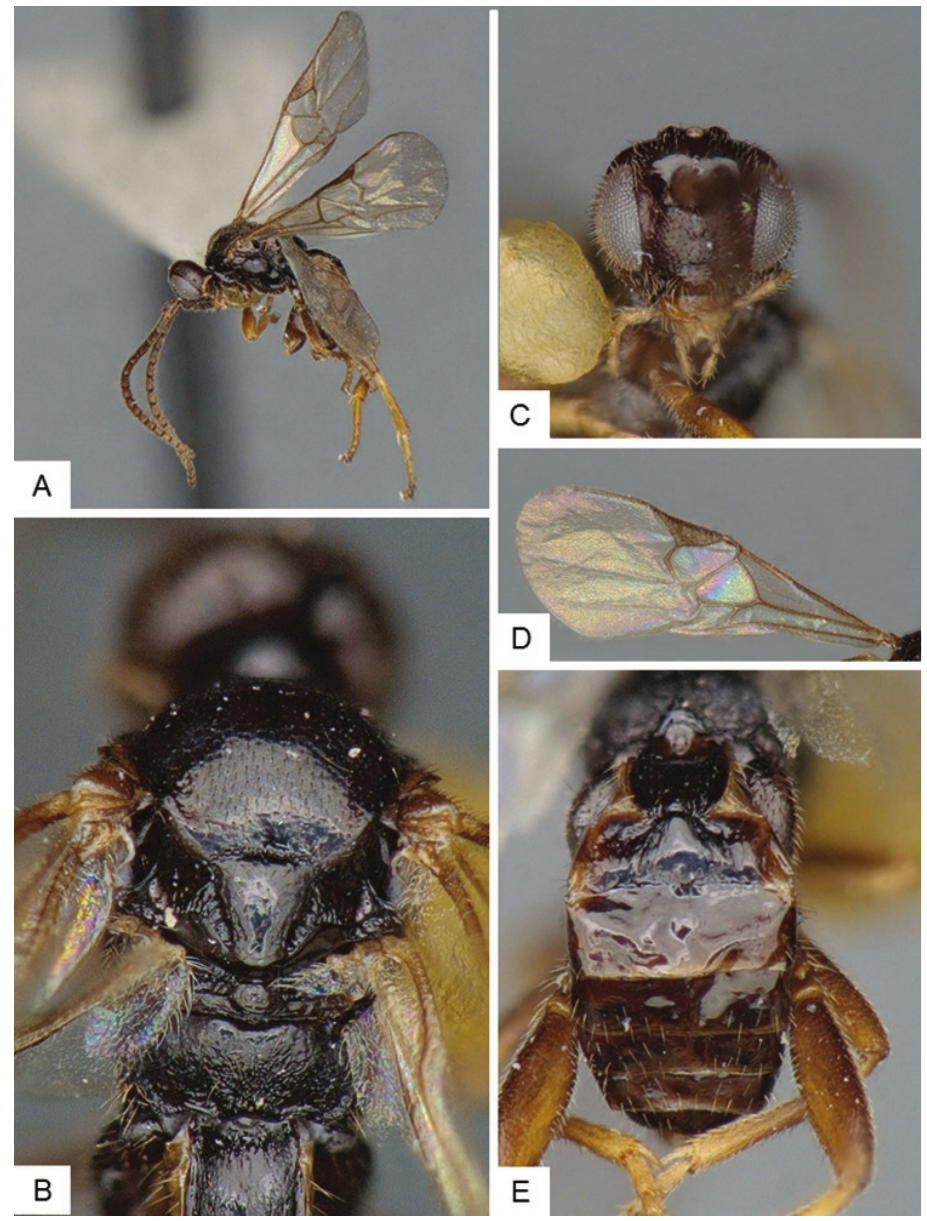
Figure 16. Glyptapanteles sp. 3. A Habitus, lateral B Mesosoma, dorsal C Head, frontal D Fore wing E Metasoma,